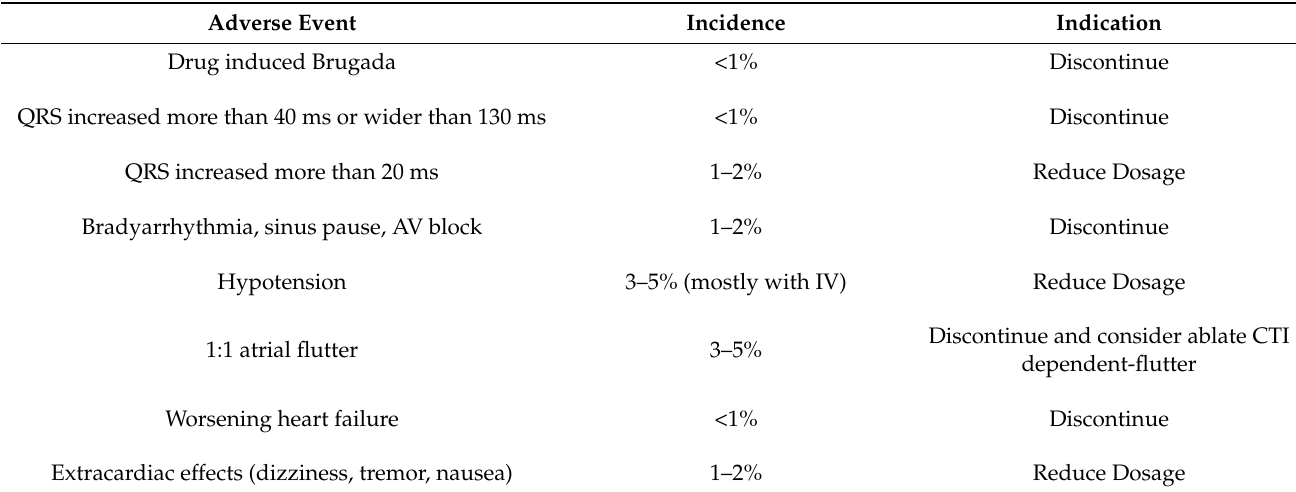
Table 2. Management of adverse events due to flecainide.